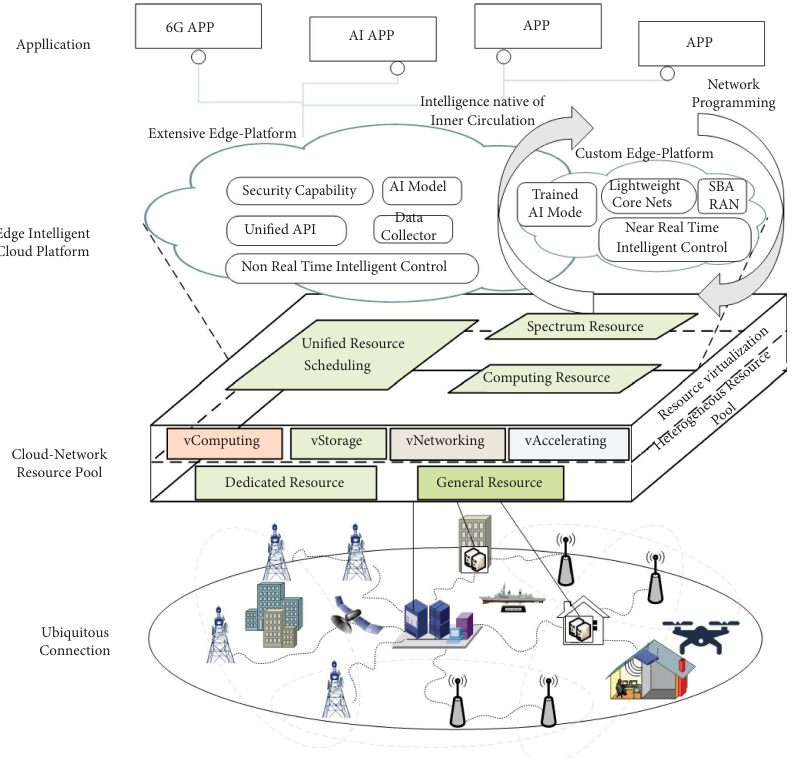
Figure 1: 6G edge intelligent RAN architecture